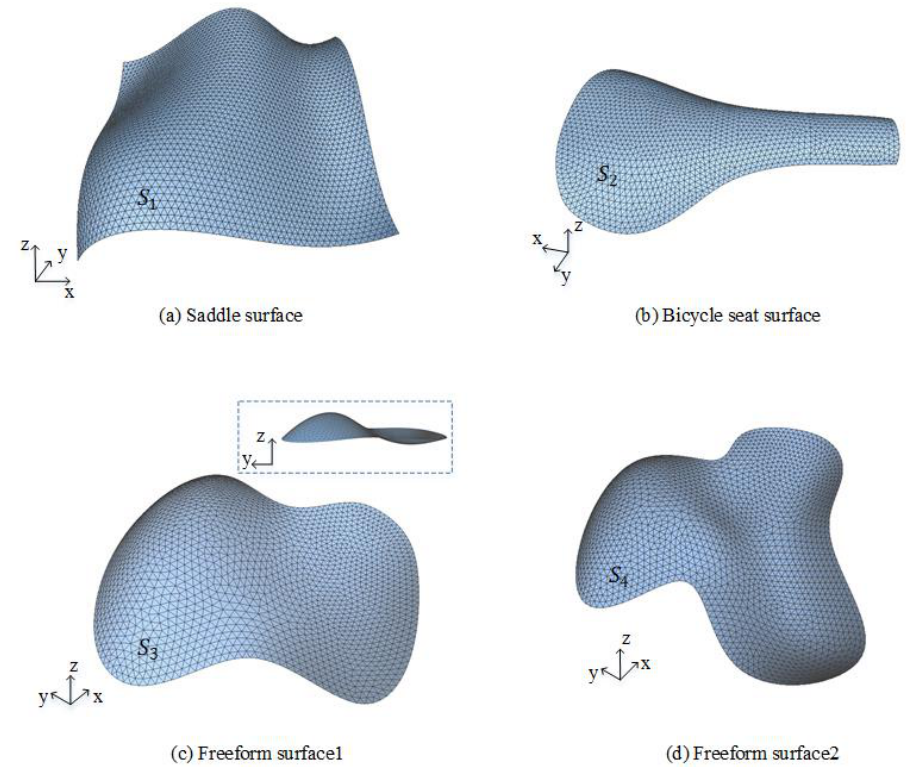
Figure 8. Four triangulated mesh surfaces used in the experiment. After running Algorithm 1 using the parameters of Table 1, the 𝑣 𝑒 (𝜃) among different feed angle 𝜃 for the four test models are computed and displayed in Figure 9, with both the optimized angle and its corresponding deposition rate annotated. For S 1 , as shown in Figure 9a, the indicator indicates several distinct local maxima, and the best of which oc- curs at 𝜃 ∗ = 158°(0.878π rad) with a maximum 𝑣 𝑒 (𝜃 ∗ ) = 0.599 mm 3 /s. For the second model, S 2 shown in Figure 9b, since the surface is symmetric about the x -axis, the indicator 𝑣 𝑒 (𝜃) shows a symmetry about 𝜃 = 90° (barring the inaccuracy due to the meshing and numerical errors), and a global maximum 𝑣 𝑒 (39° (0.217π 𝑟𝑎𝑑)) is identified. For the two freeform surfaces 𝑆 3 and 𝑆 4 (Figure 9c,d), the optimized angles are 22° and 158° , respec- tively, while there is little difference between the deposition rates with various angles, especially for 𝑆 4 . This is because, for these two surfaces, for any direction, the intersection curve between the corresponding drive plane and the surface always has portions of large curvature, which makes it difficult for Algorithm 1 to find a distinguishingly better direc- tion angle.